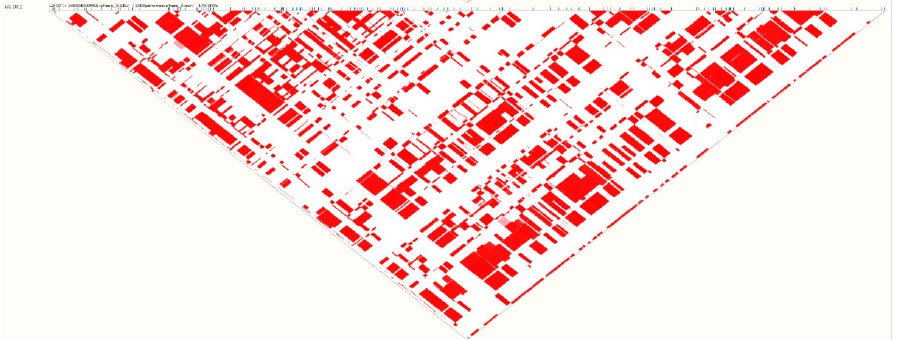
Figure 1. Linkage disequilibrium rs319013 and rs9292806 (D ′ = 1.0).